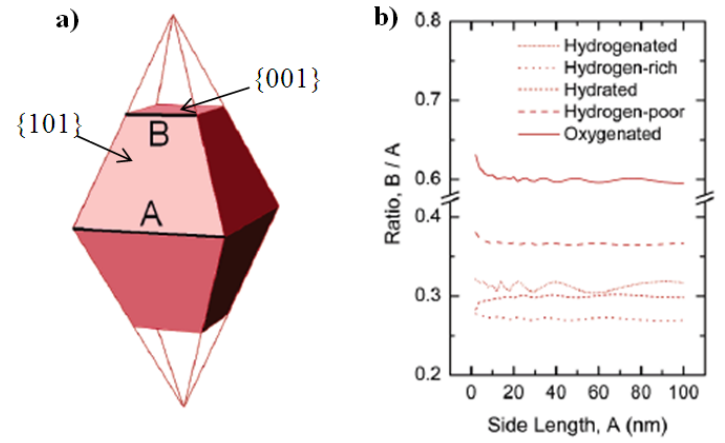
Figure 1. ( a ) An anatase tetragonal {101} bipyramid, with side lengths labeled as A and B, defining the B/A degree of truncation; ( b ) Plot of the optimized B/A ratio for anatase nanocrystals with various surface chemistries and a side length A = 2 to 100 nm. Adapted with permission from ref. [22]. Copyright 2005 American Chemical